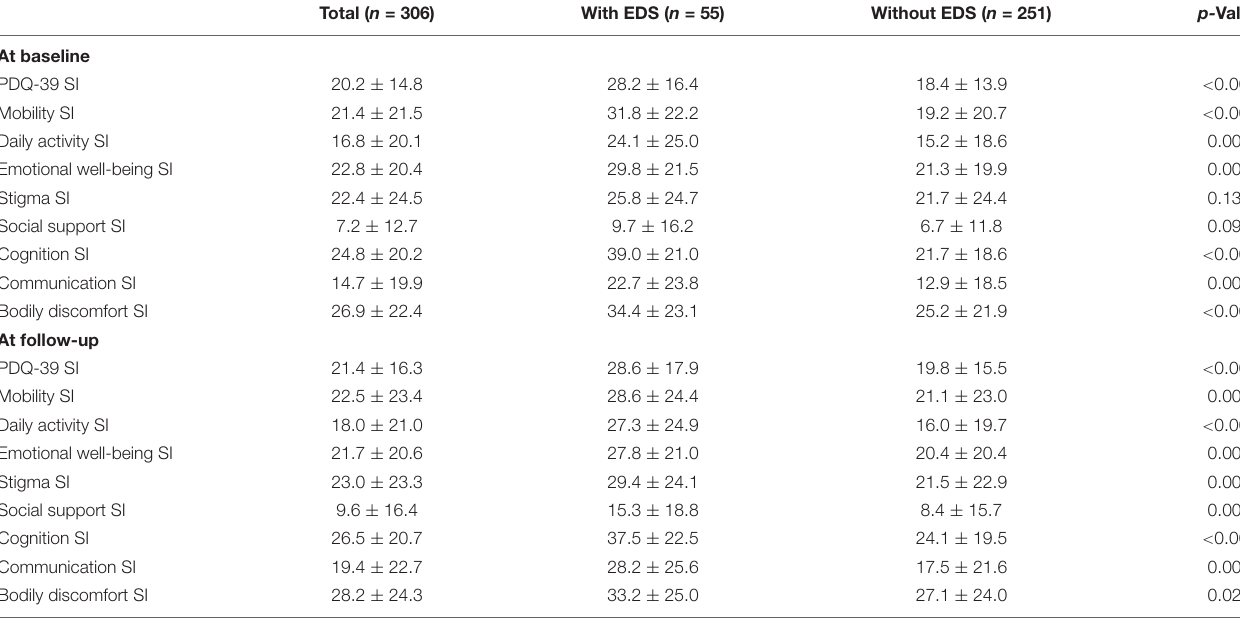
TABLE 3 | Longitudinal assessment of quality of life (QoL) in patients with Parkinson’s diseases (PD) with and without excessive daytime sleepiness (EDS).